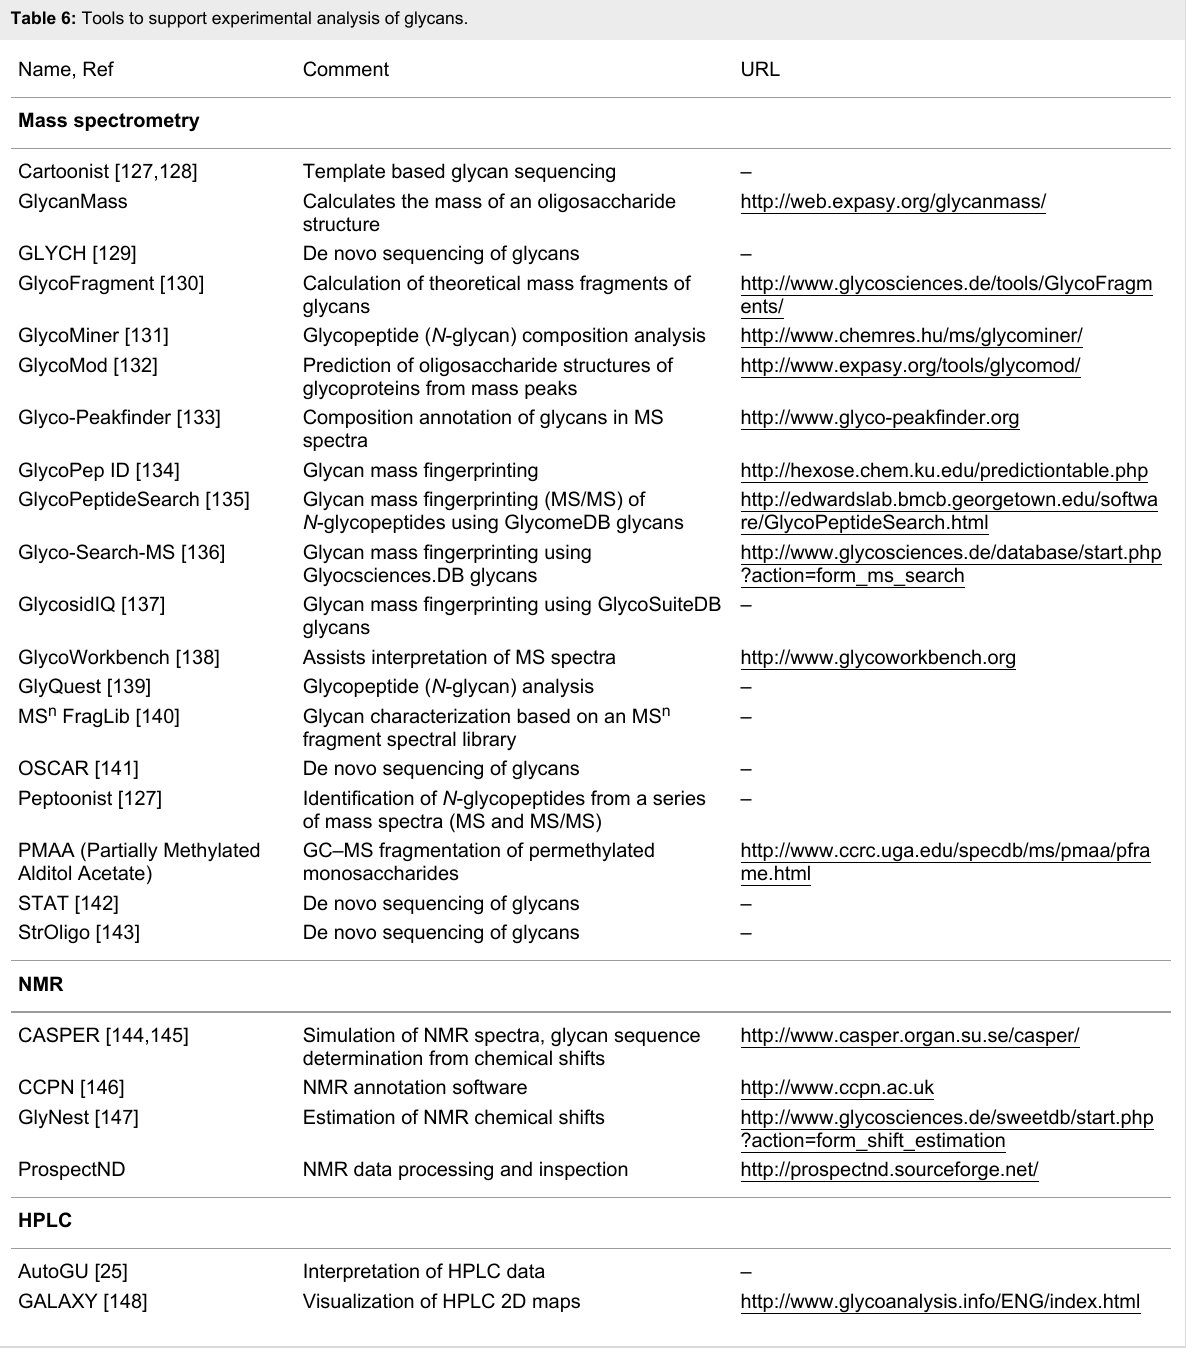
Table 6: Tools to support experimental analysis of